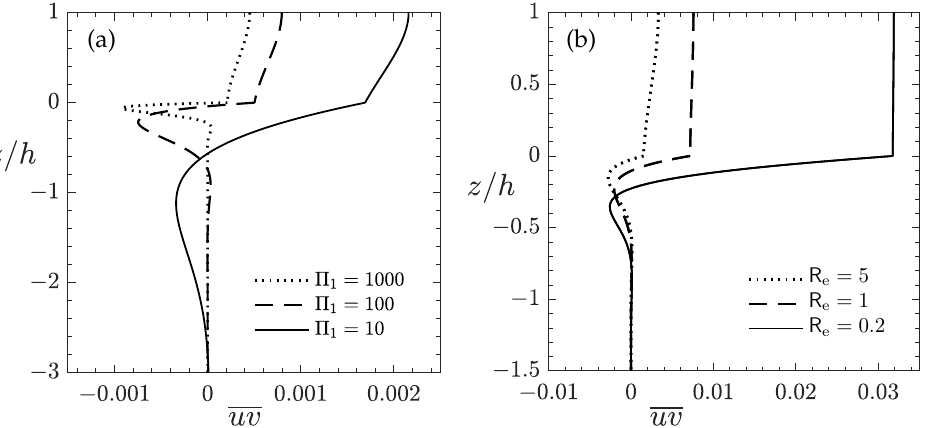
Figure 9. ( a ) Wave-induced Reynolds stress uv for ˜ ω = 0.08 with R e = 5 and varying Π 1 to show the effect of water viscosity. ( b ) uv for ˜ ω = 0.15, varying R e and keeping R e Π 1 = 500 to show the effect of ice-layer viscosity. In ( a , b ), u and v are normalized so that